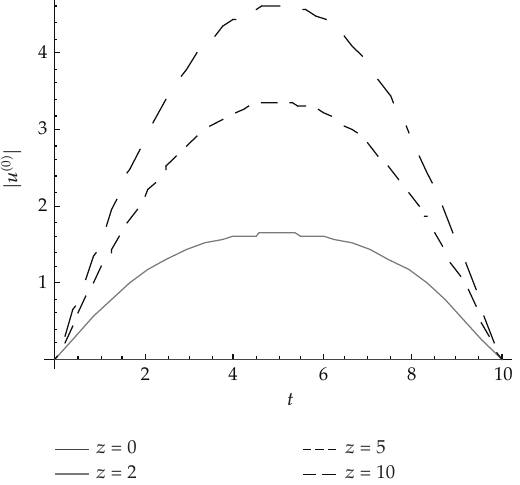
Figure 2: The zero-order approximation | u (cid:3) 0 (cid:4) | at α (cid:8) 1, T (cid:8) 10, γ (cid:8) 02 for di ff erent values of z , considering only one term in the series (cid:3) M (cid:8) 1 (cid:4)